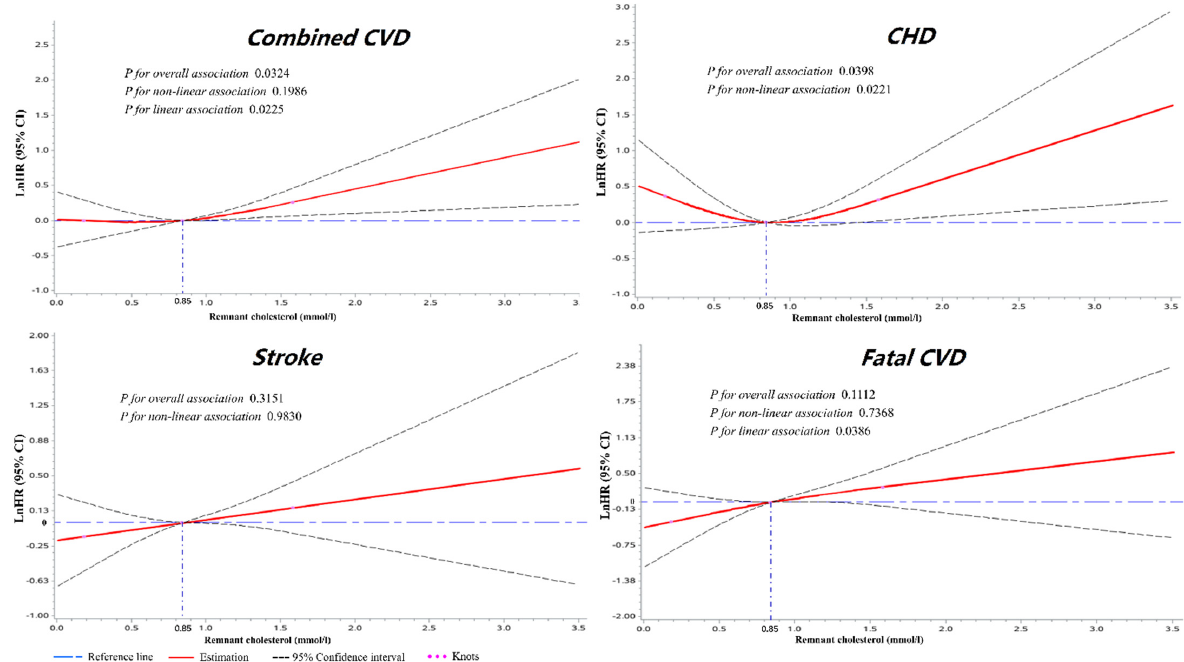
Figure 3. The dose–response associations between RC and cardiovascular outcomes for the whole cohort. Restricted cubic splines displaying the lnHRs of cardiovascular events with 95% confidence intervals according to the serum level of remnant cholesterol. Reference set to median (0.84 mmol/L). Knots located at 0.18, 0.84, and 1.58 mmol/L (at the 5th, 50th, and 95th percentiles). Adjusted for age, sex, ethnicity, body mass index, smoking status, drinking status, hypertension, diabe-